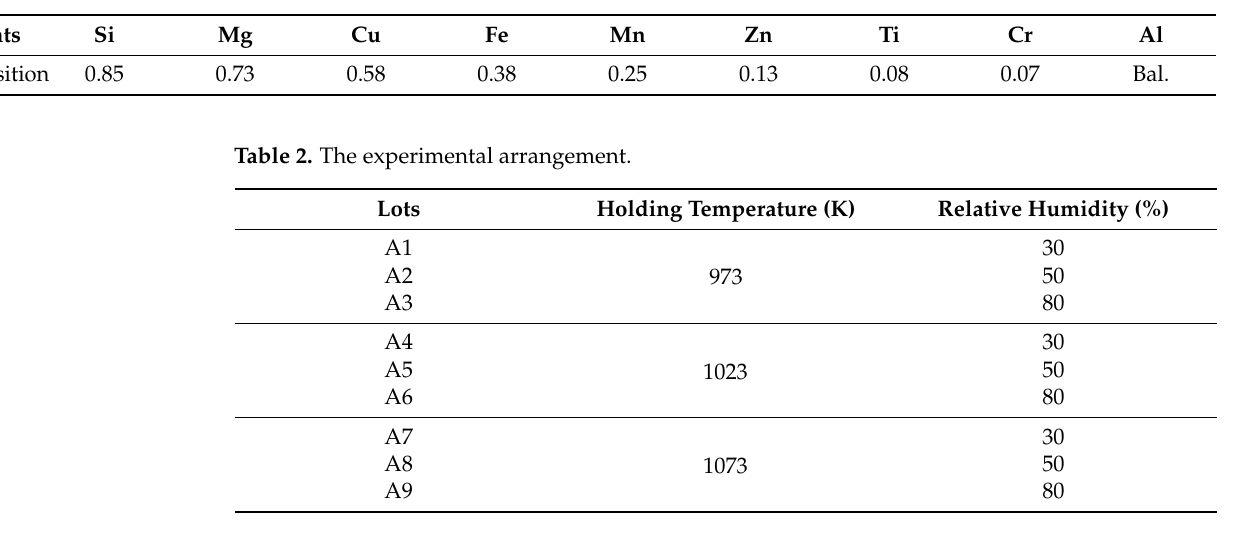
Table 1. The chemical composition of AA6111 alloys (mass fraction, wt.%).